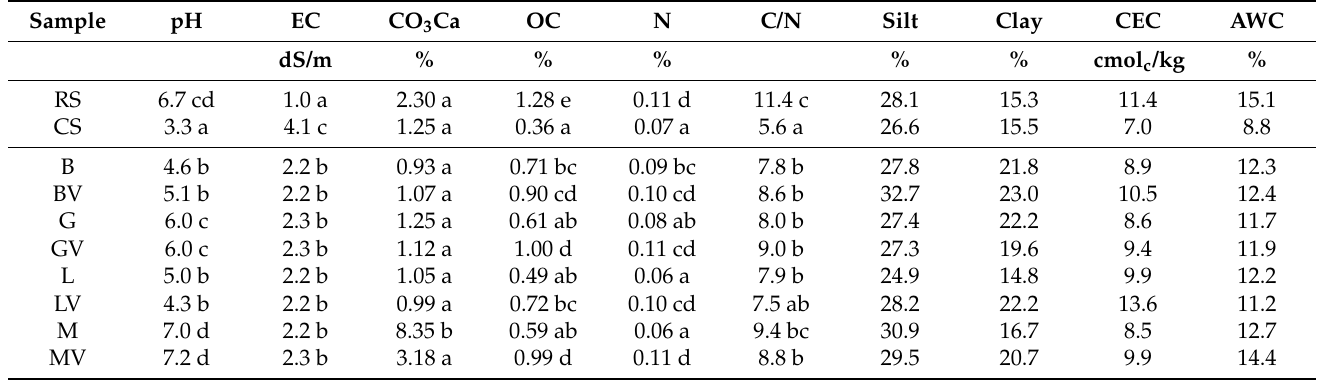
Table 2. Main soil properties for the different remediation techniques (see Table 1) one year